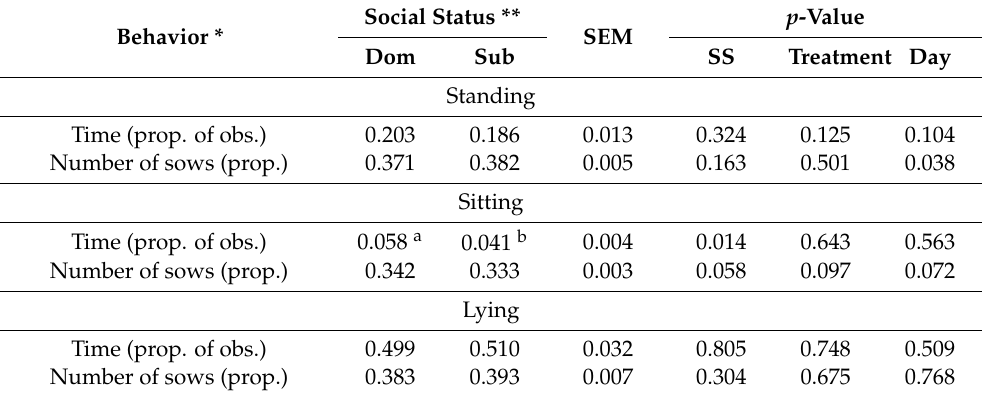
Table 6. Effects of social status, enrichment treatment and day on focal sow postures observed in photo scans. LS Means of duration (% of observations) and number of sows in each posture (% of